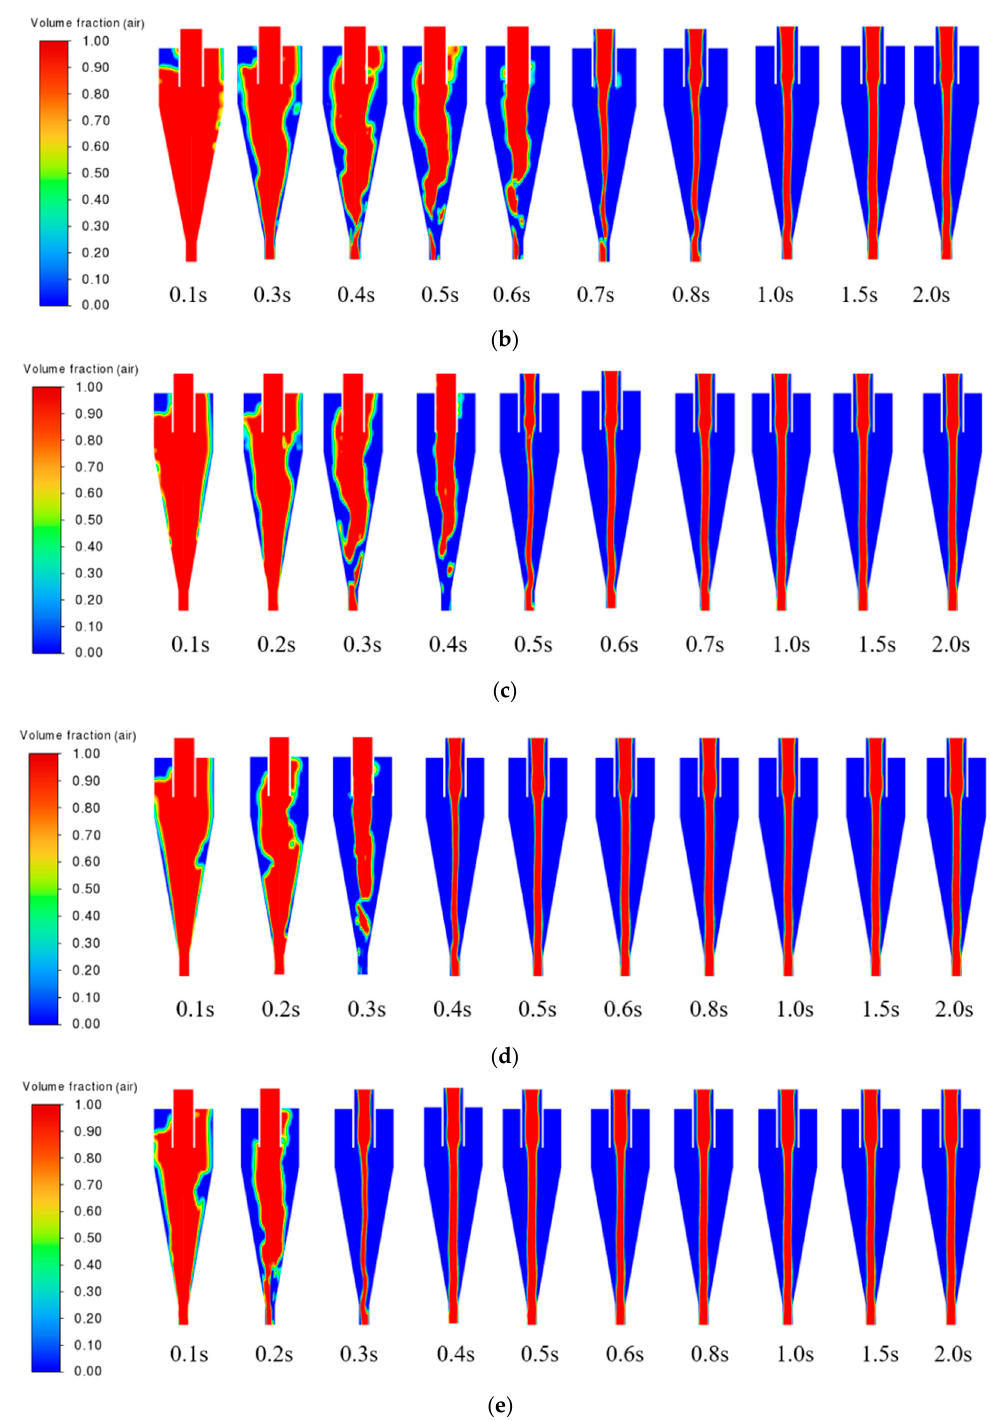
Figure 12. Development of air column under different feed rates at inlet. ( a ) Development of air column at a feed rate at inlet of 1 m/s; ( b ) Development of air column at a feed rate at inlet of 2 m/s; ( c ) Development of air column at a feed rate at inlet of 3 m/s; ( d ) Development of air column at a feed rate at inlet of 4 m/s; ( e ) Development of air column at a feed rate at inlet of 5 m/s .